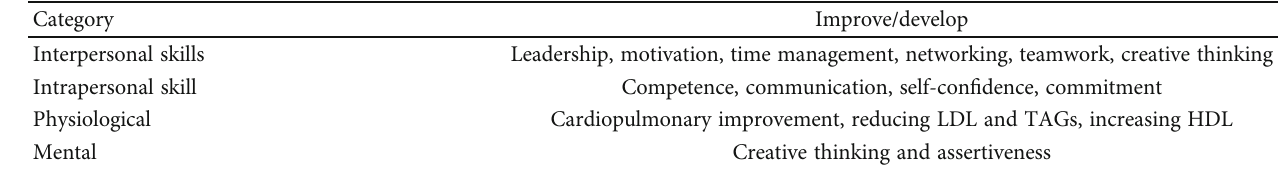
Table 4: Roles of sports and taekwondo in schooling